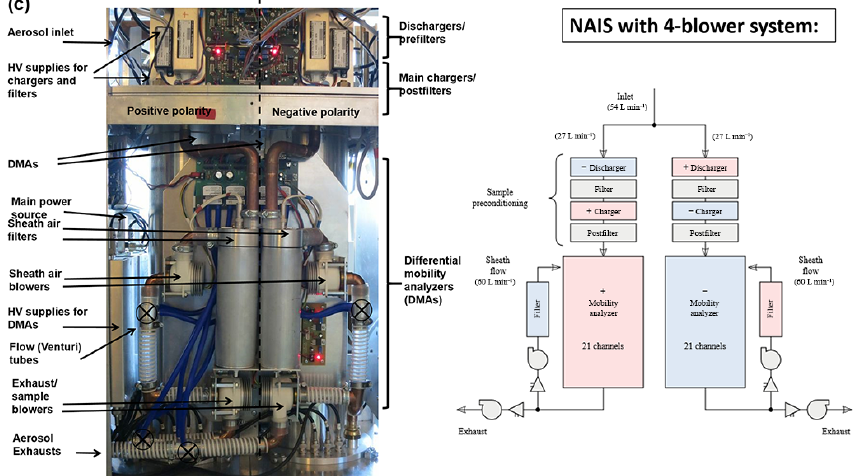
Figure 1. A schematic of the NAIS with: (a) 1-blower, (b) 3-blower, and (c) 4-blower flow system.